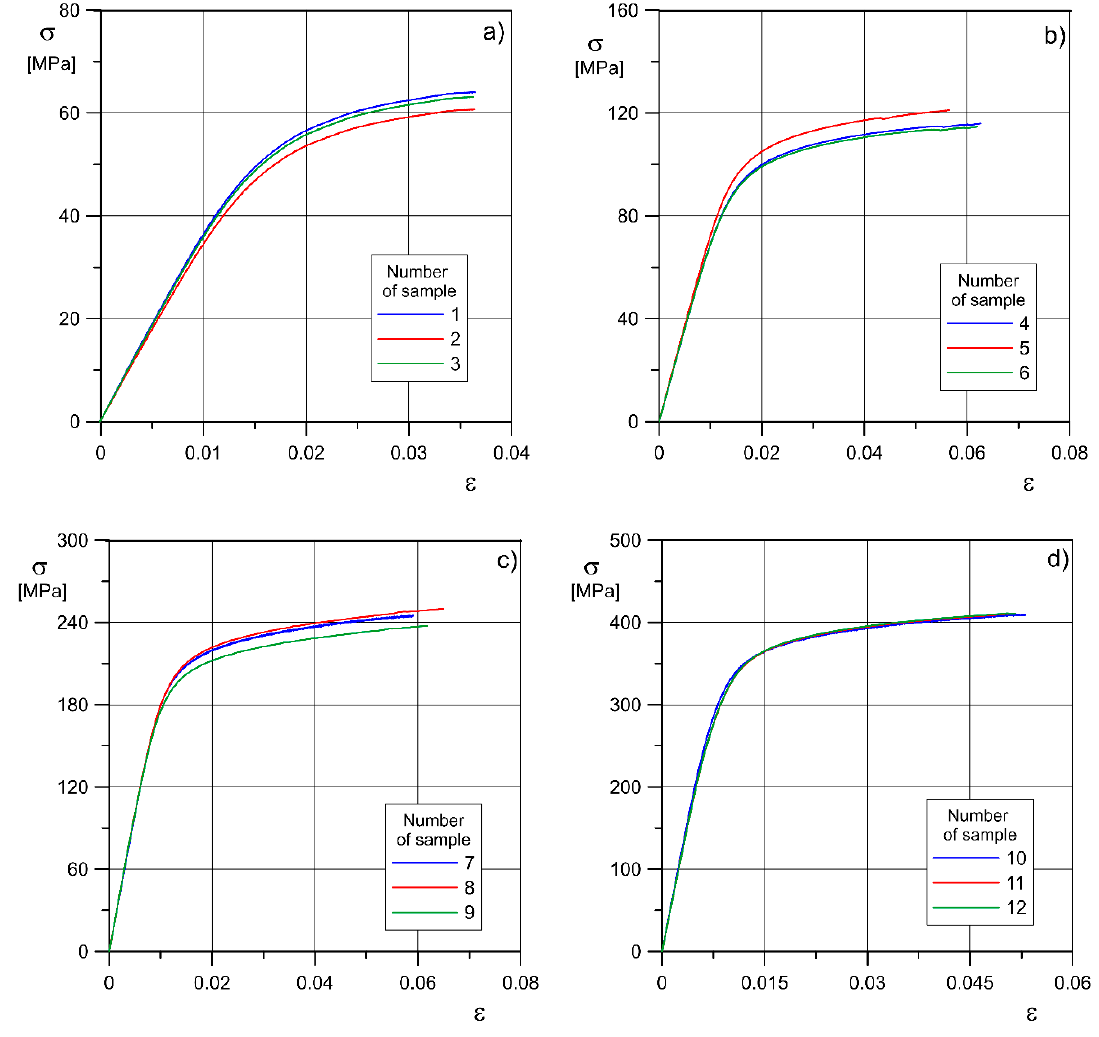
Figure 4. Dimensions of specimens for tensile testing ( a ) and specimens of Ti6Al4V titanium alloy printed by Laser Power Bed Fusion (LPBF) (before and after testing) with porosities: 81% ( b ); 73% ( c ); 50% ( d ); 34% ( e ) near 0 ( f